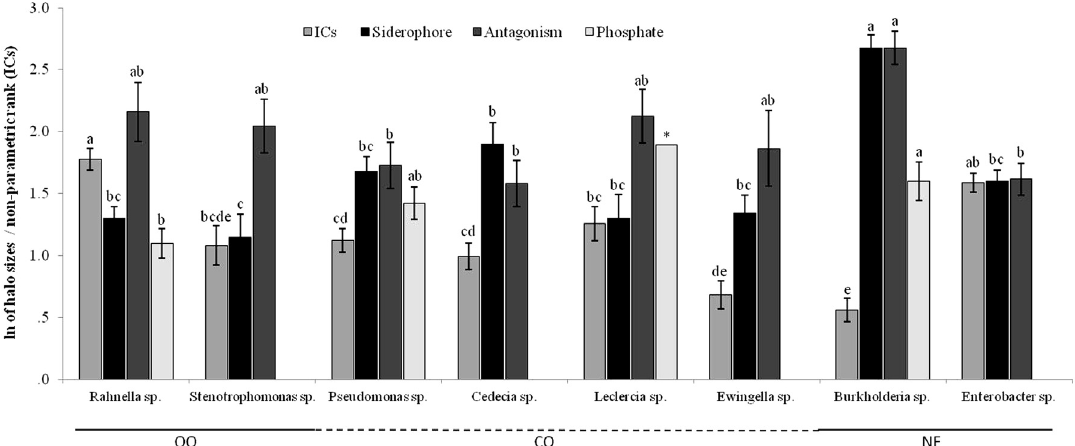
Figure 4 - PGP traits of the genera composing the core of the microbial communities (average (cid:3) SEM). Comparisons were made across each single PGP trait independently, so each statistical analysis compares bars with the same color. Siderophores, antagonism against C. gloeosporioides and phosphate solubilizationabilitieswerecomparedaccordingtohalosize.ICsproductionabilitywascomparedbynon-parametricrankingandscaleddown100times for graphical display. The genera are arranged according with the type of soil management to which they were positively associated. *= phosphate solubilization for strains belonging to Leclercia genus were removed from the statistical analysis because only one isolate presented this trait, so the stan- dard deviation could not be calculated for this genus. OO = Organic Orchard, CO = Conventional Orchard, NF = Native Field.